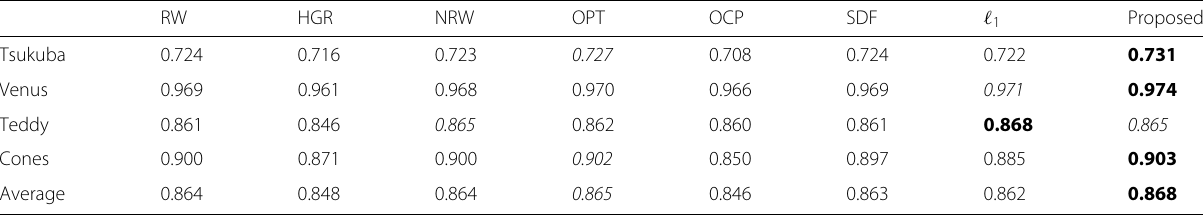
Table 2 SSIM of estimated depth on Middlebury datasets when cross-boundary scribbles are present RW